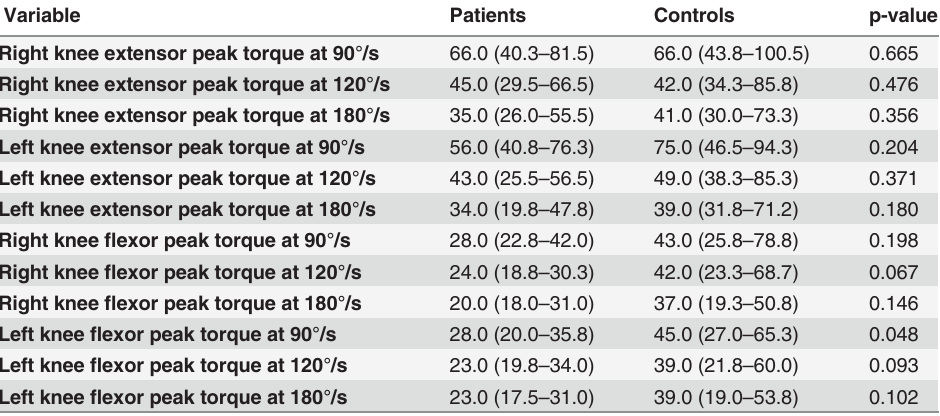
Table 3. Extensor and flexor muscle strength (peak torque) at 90°/s, 120°/s and 180°/s in Patients and Controls.